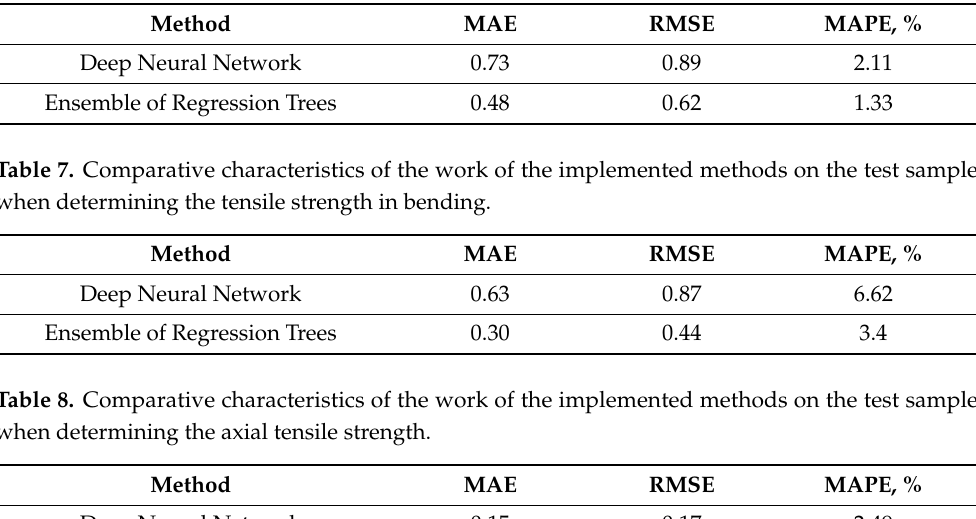
Table 6. Comparative characteristics of the work of the implemented methods on a test sample when determining the prism compressive strength.